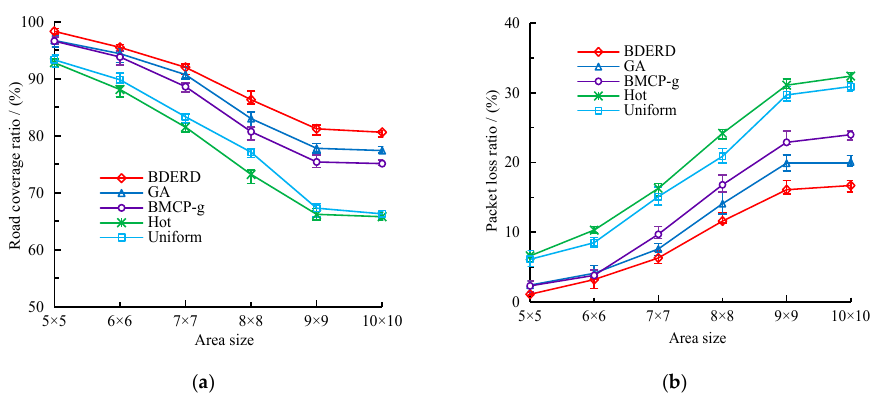
Figure 7. ( a ) Road coverage ratio versus the area size; ( b ) packet loss ratio versus the area size.